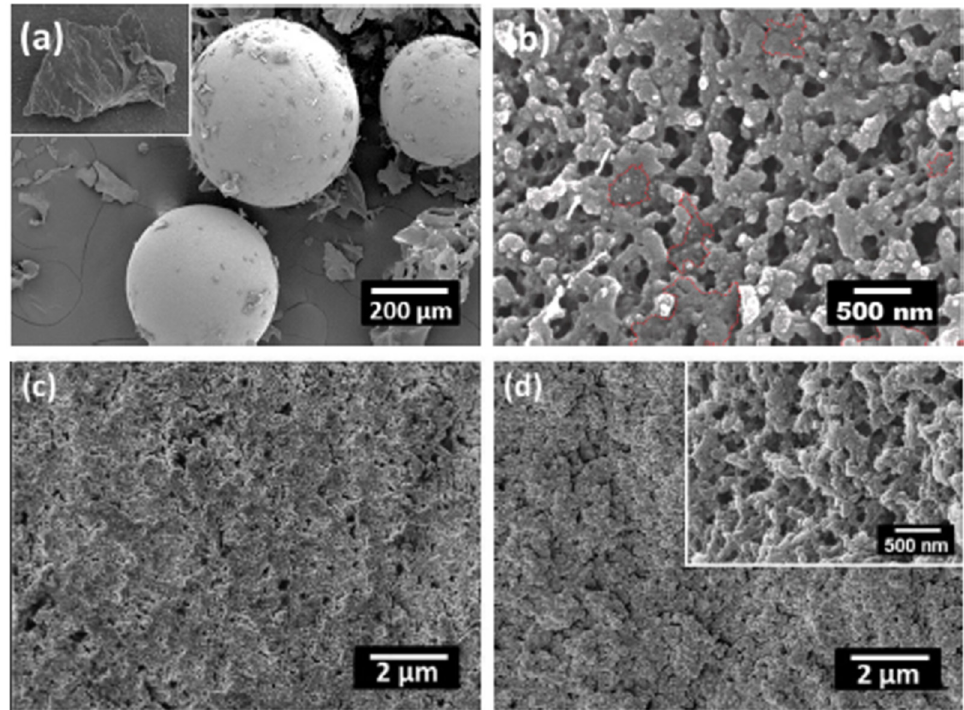
Figure 7. SEM images of ( a ) Arg-PMMA with inset image of microsized crystal of arginine, ( b ) inside structure of Arg-PMMA, ( c ) surface structure of (EMIM)(Lys)-PMMA and ( d ) cross-sectional structure of (EMIM)(Lys)-PMMA ( a , b ): Reproduced with permission from Wang et al. [79], published by American Chemical Society (2013)) ( c , d ): Reproduced with permission from Jiang et al. [52], published by Elsevier (2013)).